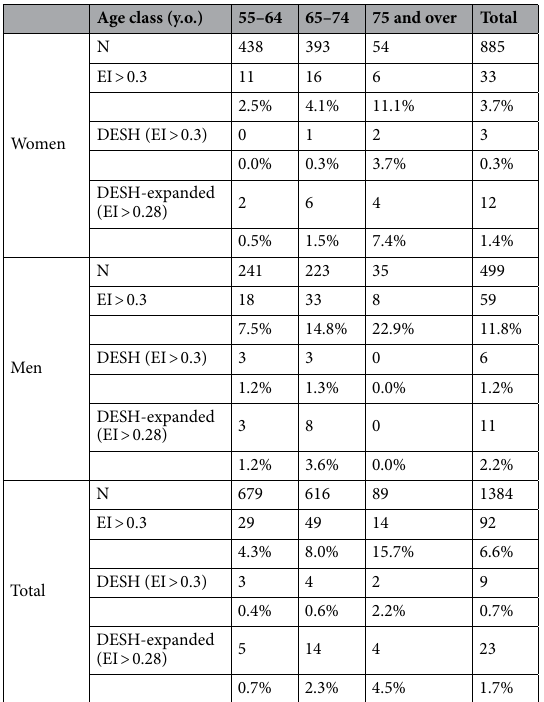
Table 2. The prevalence of EI > 0.3, DESH and DESH-expanded stratified by age class and sex. EI Evans index, DESH disproportionately enlarged subarachnoid space hydrocephalus (EI > 0.3). DESH-expanded; the criterion of EI for diagnosing DESH was expanded to >